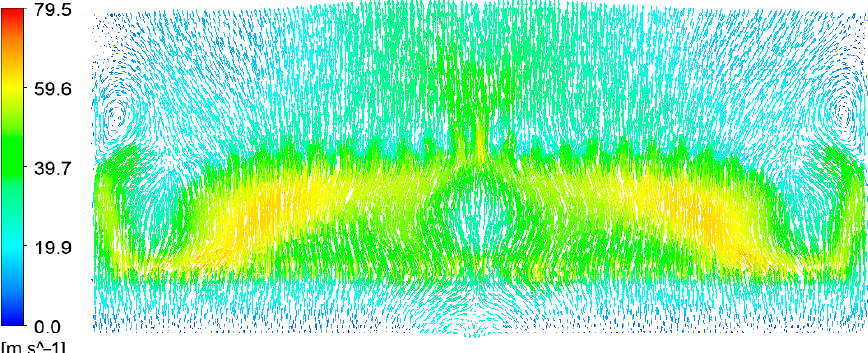
Figure 16. Velocity vector diagram of cross section 4 after optimization.